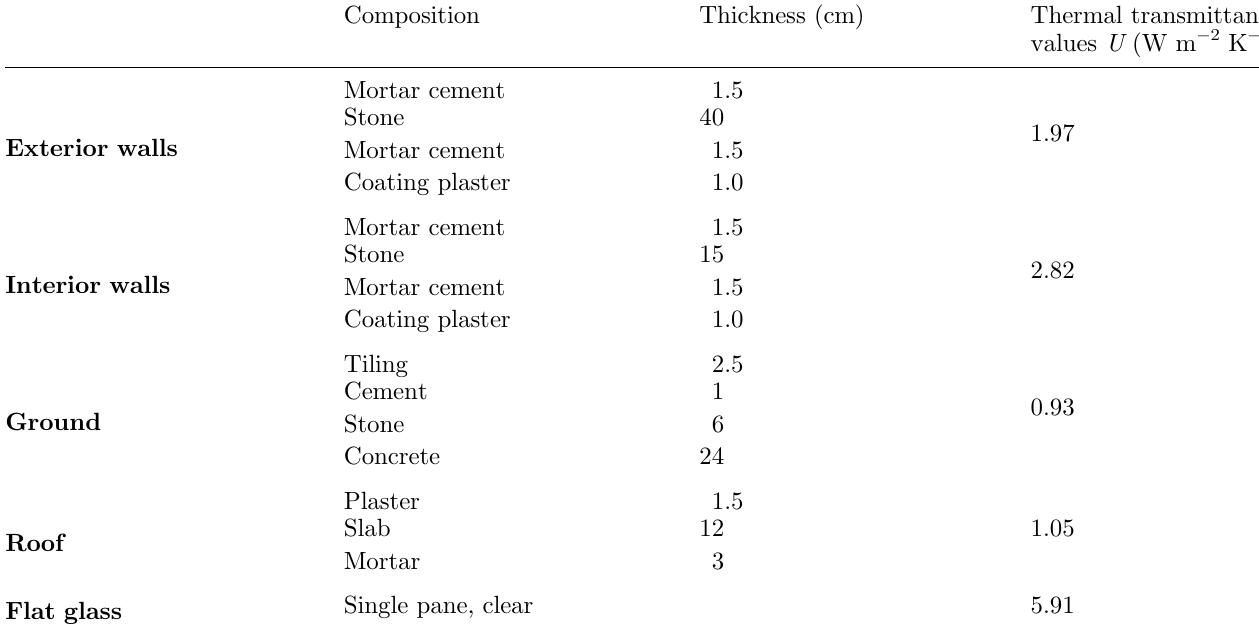
Table 1. Layer thickness, walls composition and U values for building